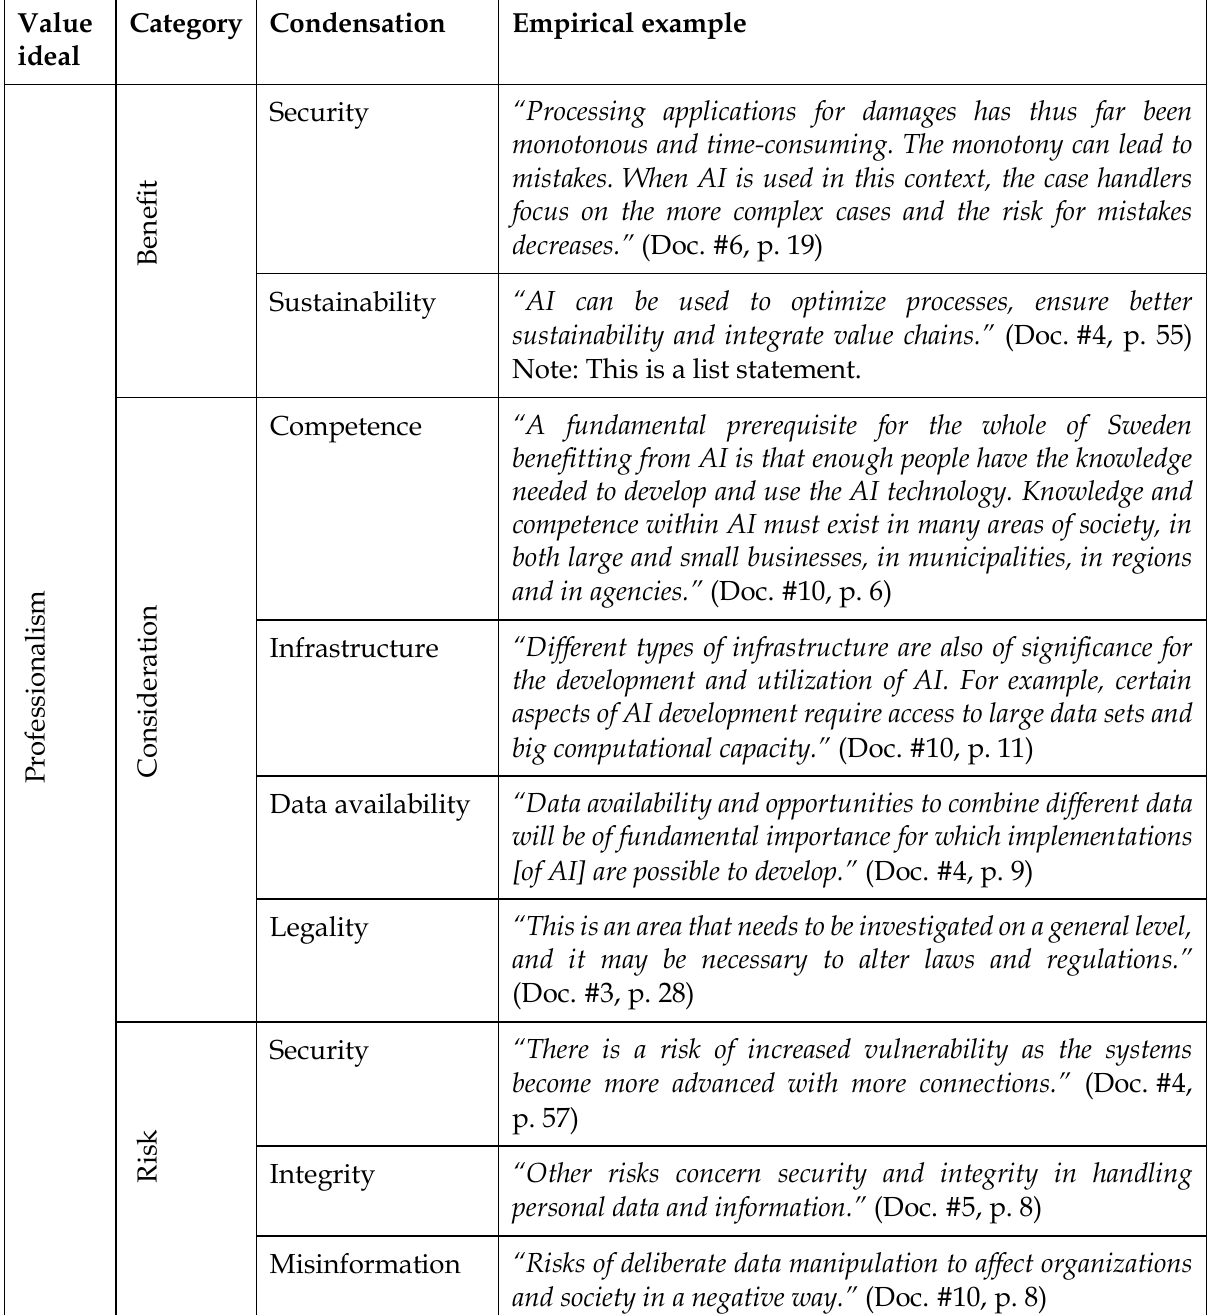
Table 6. Empirical examples of condensations and their cate gories for the ‘Professionalism’ value